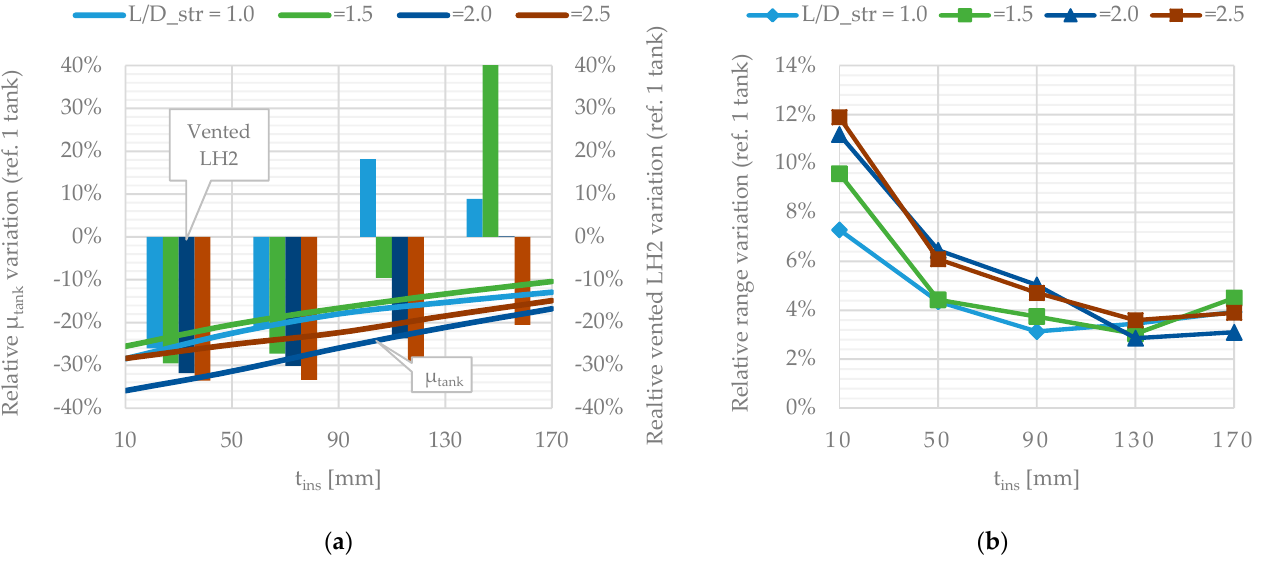
Figure 21. Comparison between 2 tanks and 1 tank configurations with the same embarked LH 2 : ( a ) relative 𝜇 (cid:3047)(cid:3028)(cid:3041)(cid:3038) and vented LH 2 variations, ( b ) relative range variation (reference values: 1 tank). By setting 𝐿 𝐷 (cid:3046)(cid:3047)(cid:3045) ⁄ = 2.5 and 𝑡 (cid:3036)(cid:3041)(cid:3046) = 50 mm, it was observed that, compared to the case